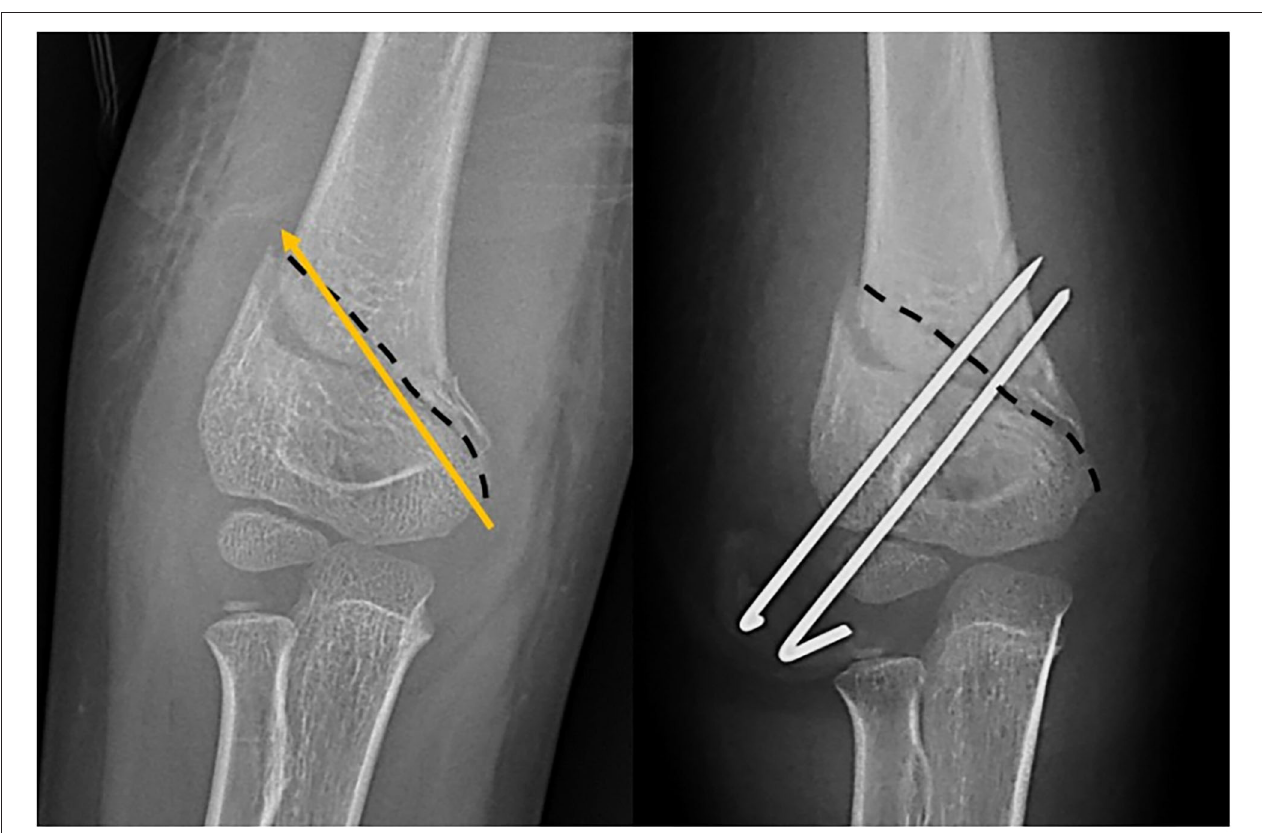
FIGURE 5 | The dashed line demonstrates the lateral high-long oblique fracture. The arrow shows that the medial wire cannot insert in these kinds of fracture